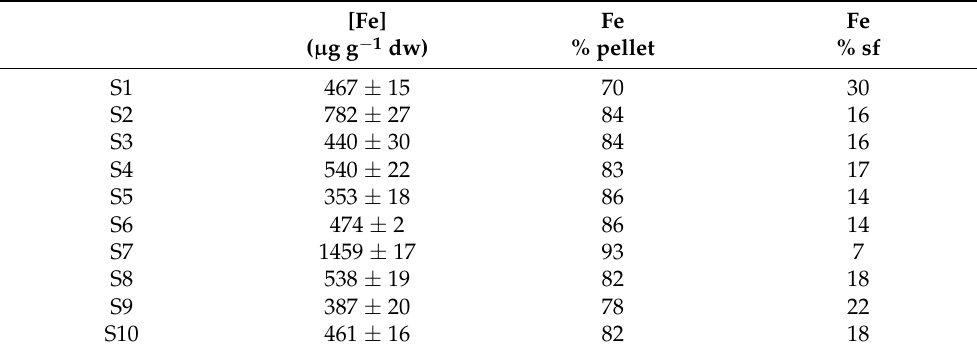
Table 1. Iron content in ten commercial samples (S1–S10) of Arthrospira spp. sold as dietary supple- ment. Data are expressed as µ g g − 1 dw and are reported as mean ± SD (n = 3). The distribution of iron between the pellet and the soluble fraction (sf) is reported as percentage.